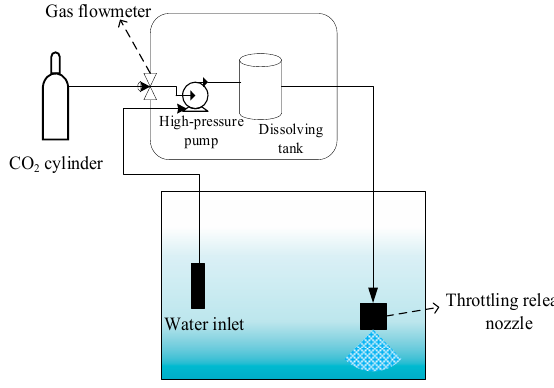
Figure 1. Schematic illustration of MNB generator.